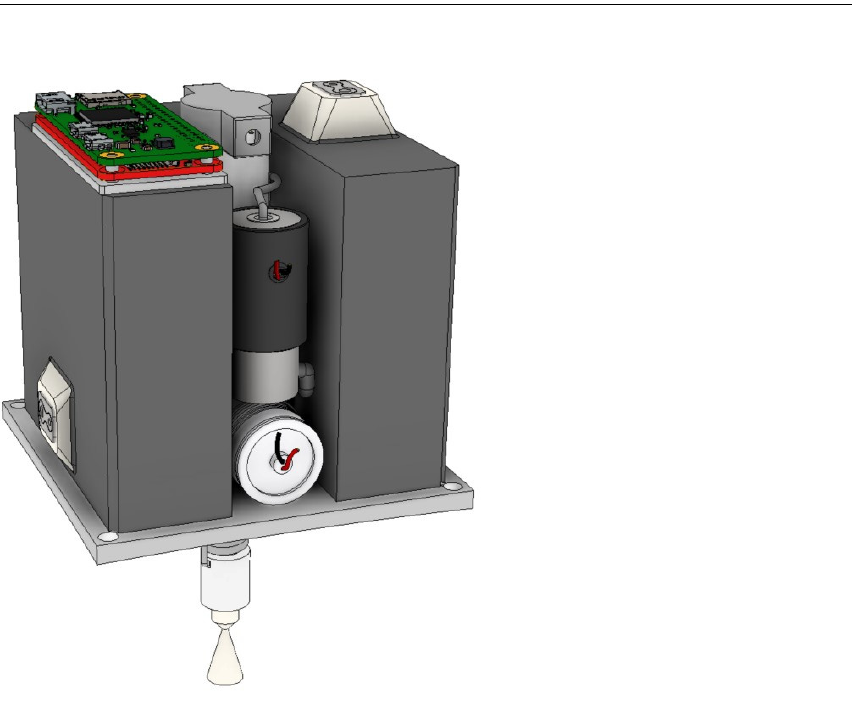
Figure 7. MIMPS-G500mN main module showing the tank shape and different system components. Table 9. MIMPS-G total impulse I tot with the selected green monopropellants.